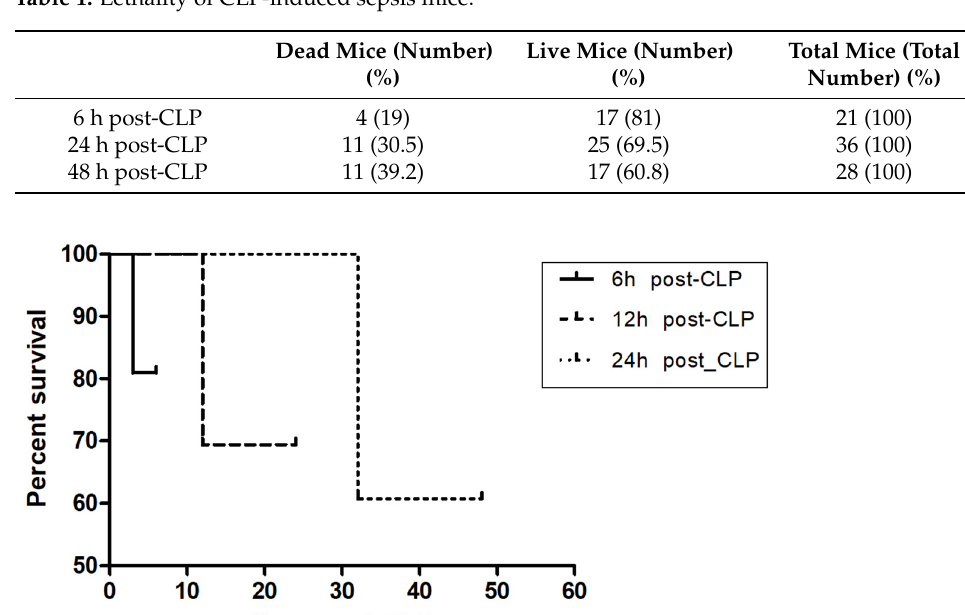
Table 1. Lethality of CLP-induced sepsis mice.